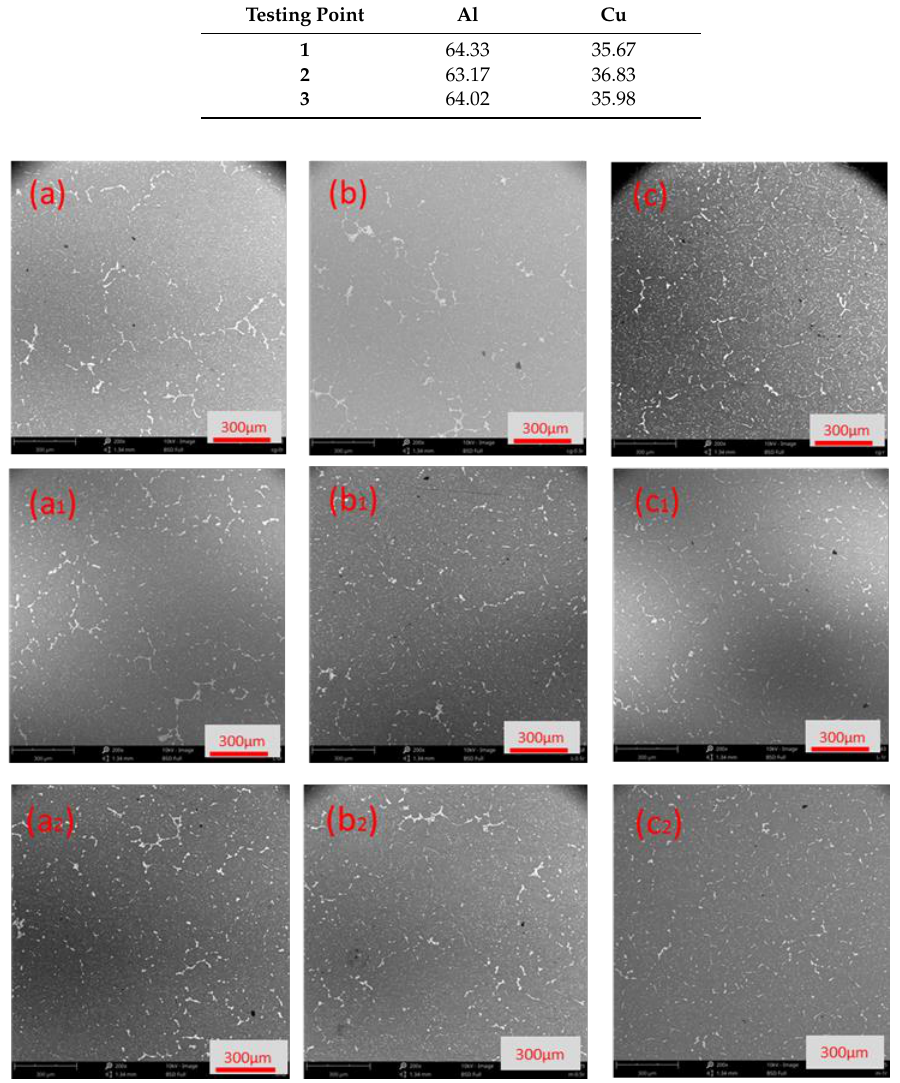
Figure 8. Phases of ingots under different processing parameters: ( a – c ) positions of 0R, 0.5R, R of NO-UTS ingot; ( a 1 – c 1 ) positions of 0R, 0.5R, R of I-UTS ingot; ( a 2 – c 2 ) positions of 0R, 0.5R, R of the L-UTS ingot.